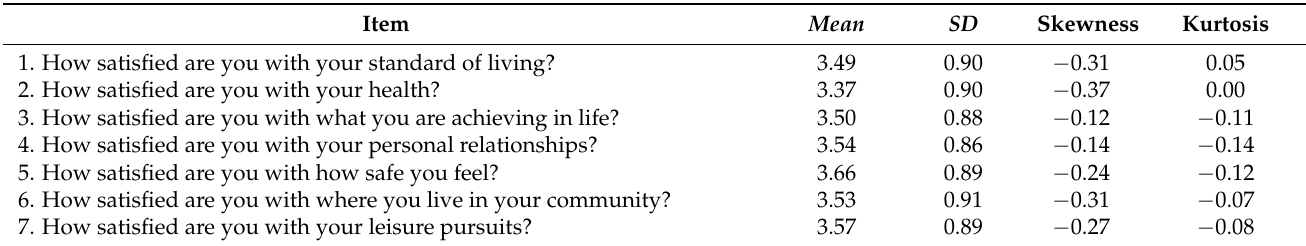
Table A10. Descriptive analysis of wellbeing satisfaction ( n = 595, 2021 sample).